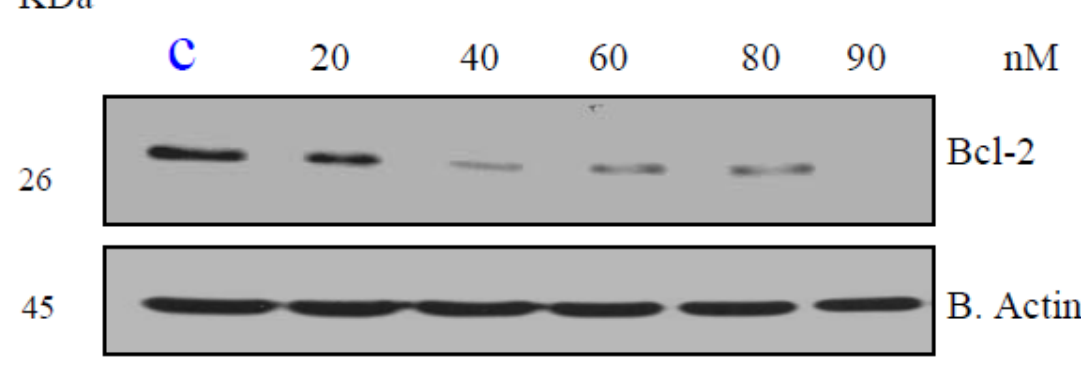
Figure 2. Expression of bcl-2 in HeLa cells exposed to17- β -estradiol (20, 40, 60, 80, and 90 nM) for 24 h. Western blot analysis of bcl-2 expression was performed as indicated in the Materials and Methods. Beta actin expression was used to assess equal lane loading.